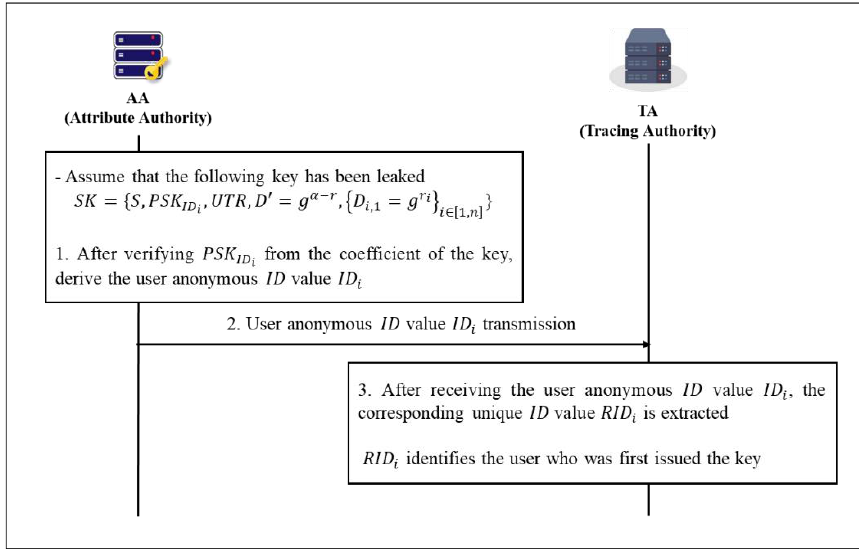
Figure 10. Tracing the User Who First Issued the Key Phase.